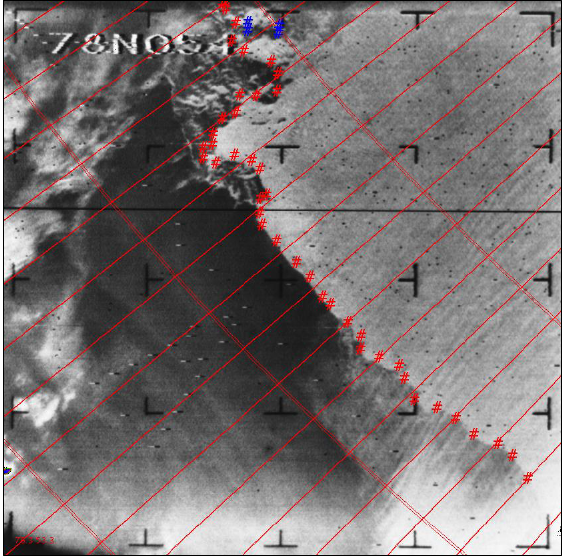
Fig. 3. Outline of Antarctic sea ice edge from Nimbus I AVCS im- agery using manual analysis. Solid blue lines represent minimum (more southern) and maximum (more northern) estimates of the ice edge in the manual analysis. Black dots represent the average or “best estimate” of the ice edge. The pink line is the 1979–2000 me- dian ice edge from the passive microwave-based NSIDC Sea Ice Index product.